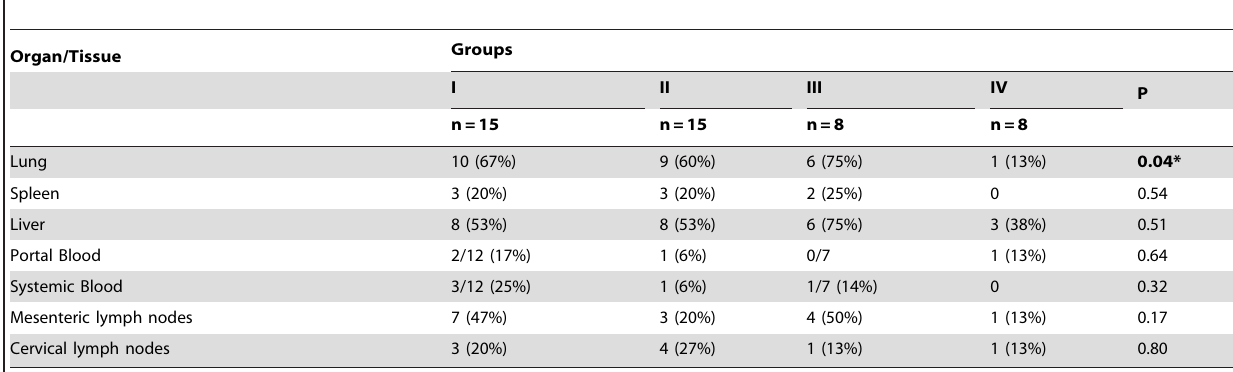
Table 3. Number and proportion of rats with positive microbiological growth for strains of extended-spectrum beta-lactamase producing E. coli in organs and